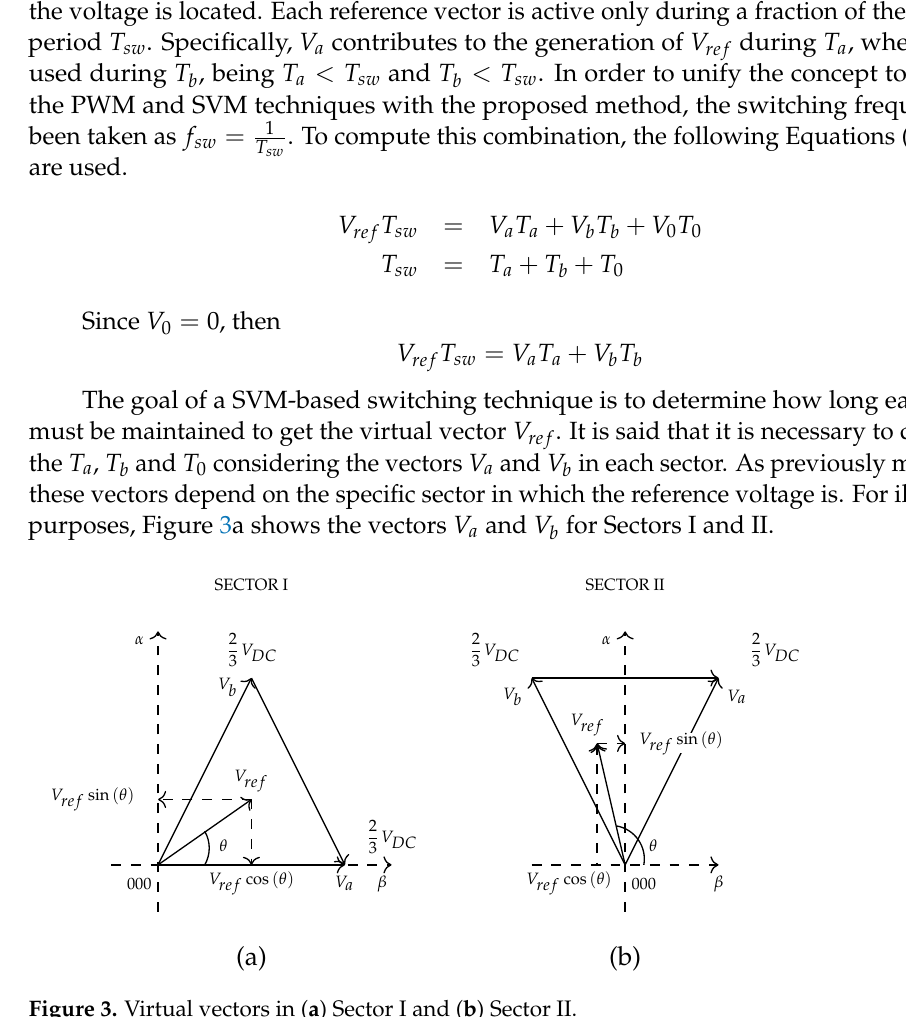
Figure 3. Virtual vectors in ( a ) Sector I and ( b ) Sector